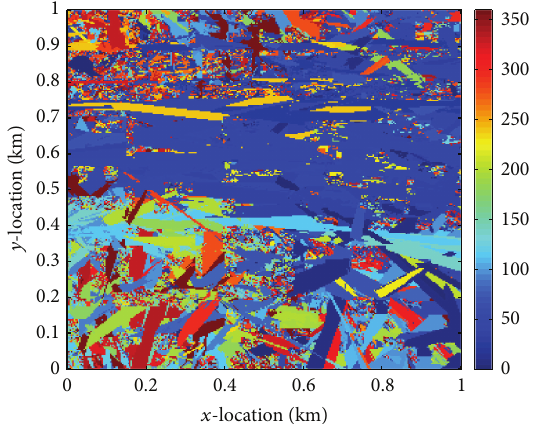
Figure 3: Simulated AOA in azimuth plane ( ∘ ) data from the MCD for downtown State College, PA, for Scenario A. Data plotted for the dominant multipath.